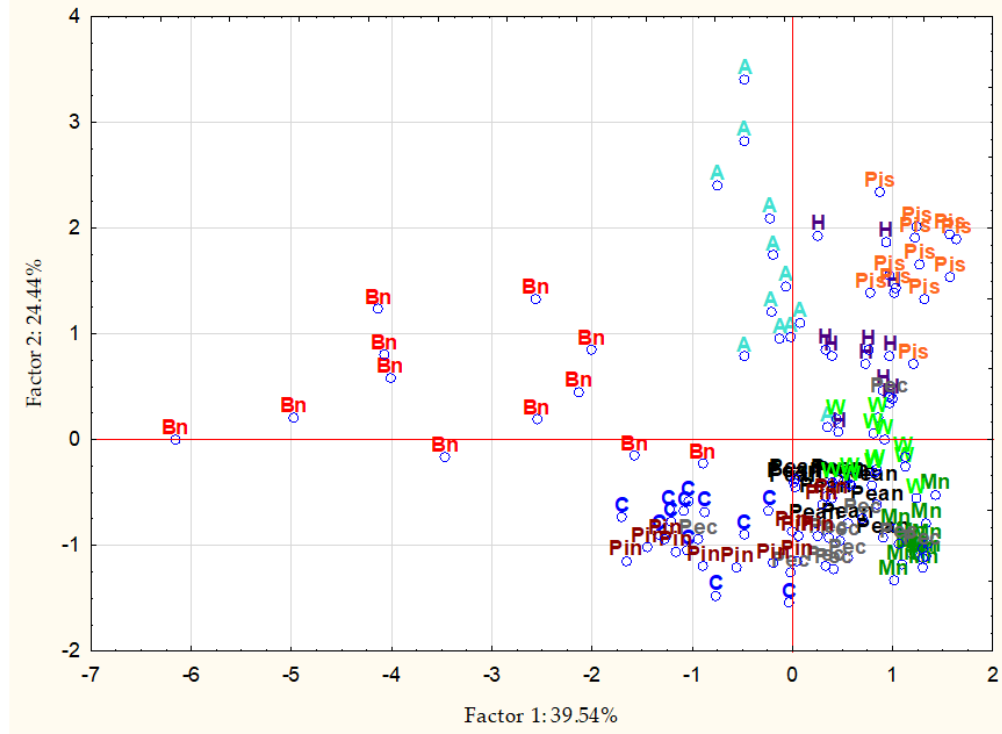
Figure 2. Principal component analysis scatter plot for factors 1 and 2. Abbreviations: